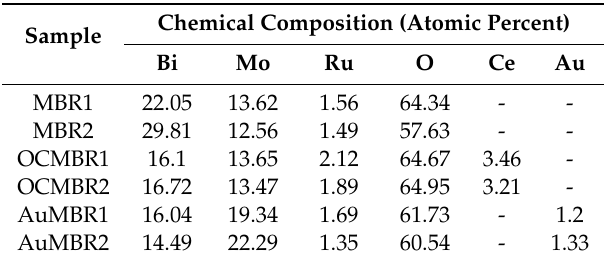
Table 1. Elemental chemical analysis (atomic percent) obtained by energy-dispersive X-ray spectroscopy (EDS) using an EDAX